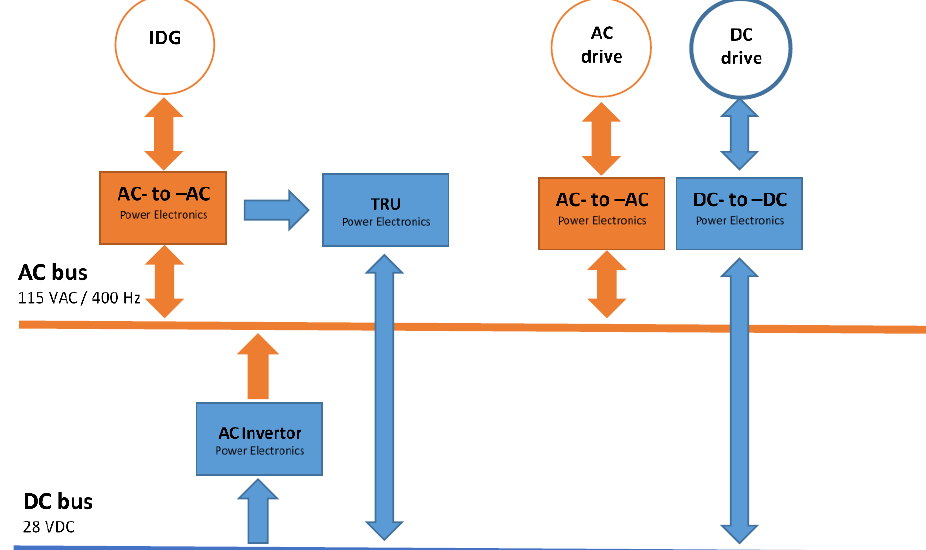
Figure 2. Power processing of onboard aircraft electronics.